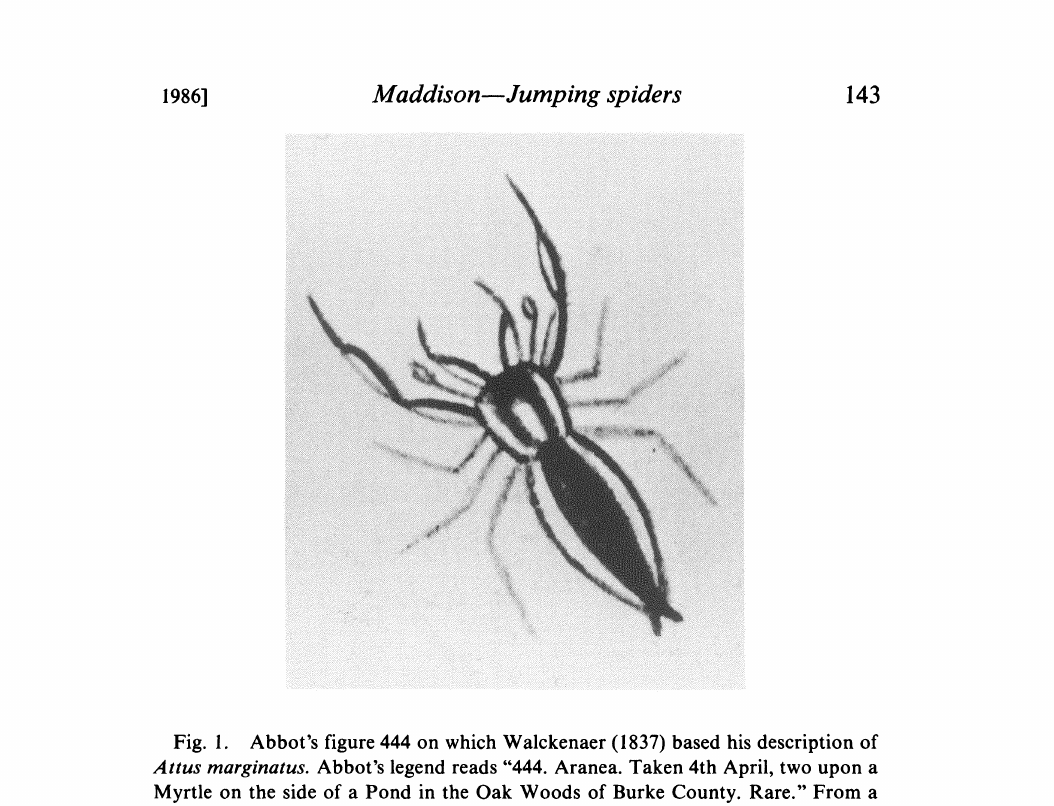
Fig. 1. Abbot’s figure 444 on which Walckenaer (1837) based his description of Attus marginatus. Abbot’s legend reads "444. Aranea. Taken 4th April, two upon a Myrtle on the side of a Pond in the Oak Woods of Burke County. Rare." From a color slide taken by Allen Brady of Abbot’s (1792) original in the British Museum (Natural